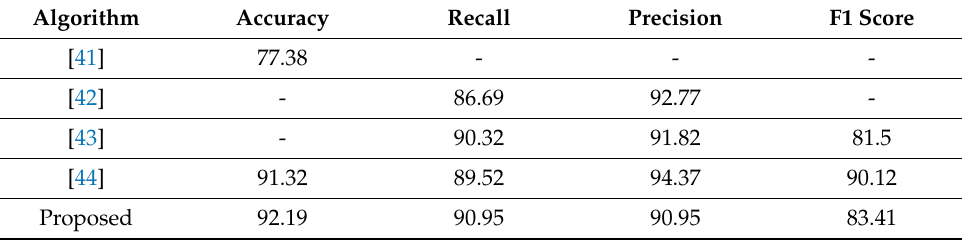
Table 3. Comparison among the results obtained by the proposed method and those obtained by state-of-art